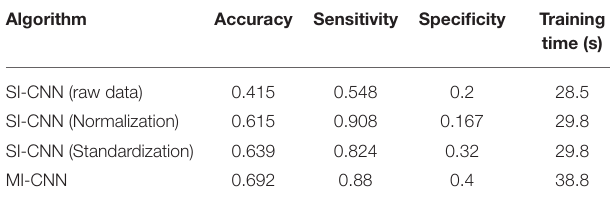
TABLE 2 | Results of neural networks with different data preprocessing methods on the walking dataset.